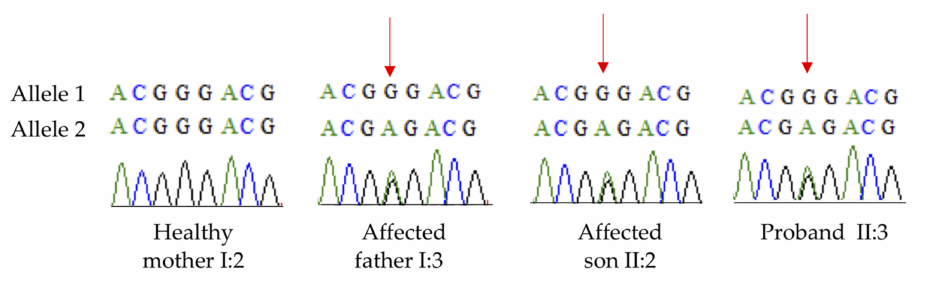
Figure 3. Confirmation of variant by Sanger sequencing of affected and unaffected family